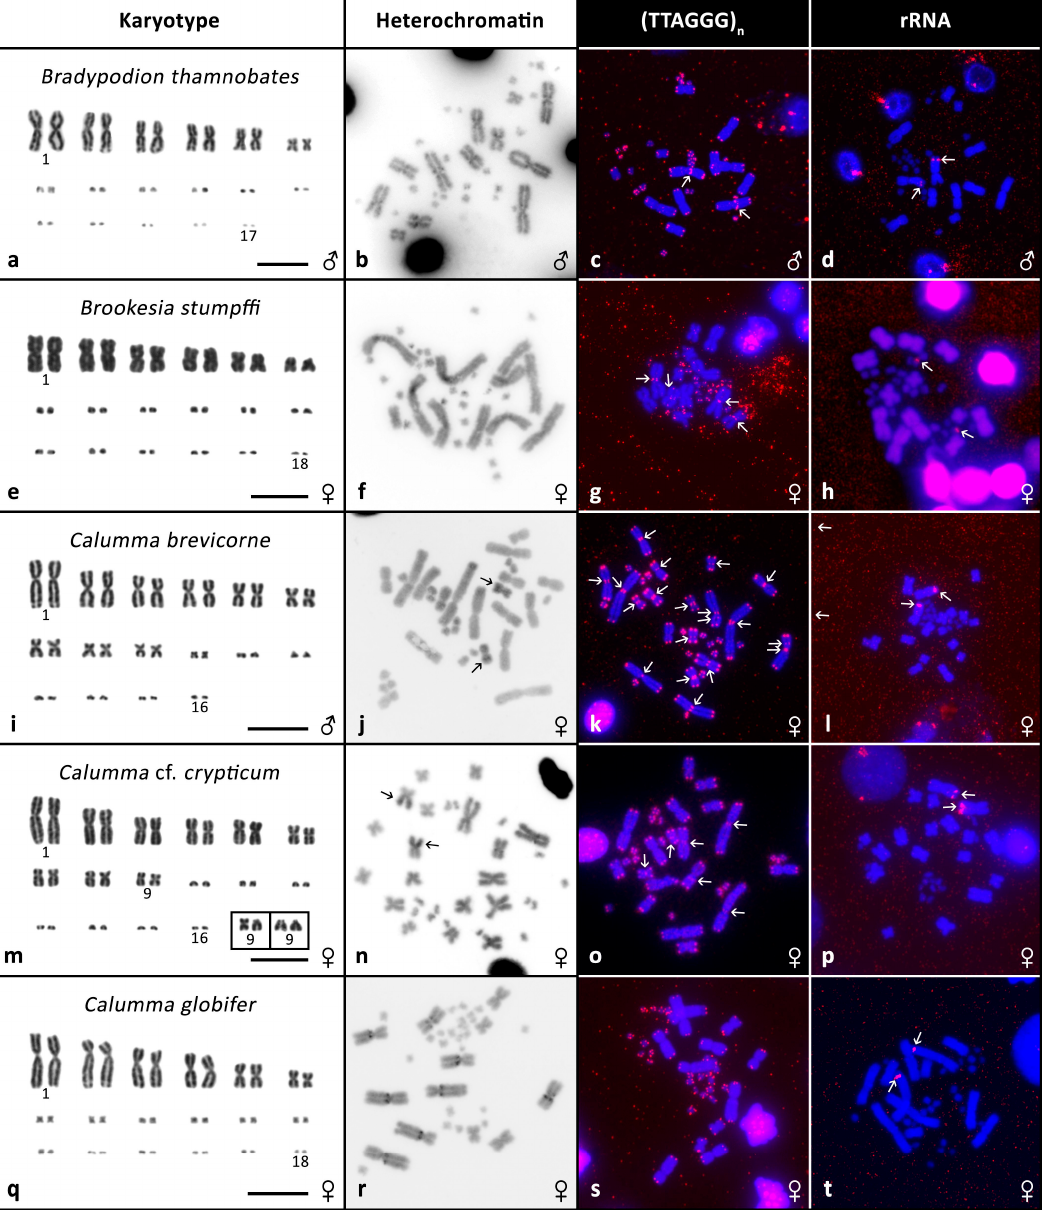
Figure 1. Cytogenetic data. Giemsa stained karyotypes ( a , e , i , m , q ), C-banding ( b , f , j , n , r ), fluorescence in situ hybridization (FISH) with telomeric probe ( c , g , k , o , s ) and FISH with rRNA probe ( d , h , l , p , t ) in Bradypodion thamnobates , Brookesia stumpffi , Calumma brevicorne , Calumma cf. crypticum , Calumma globifer . Arrows indicate signals.